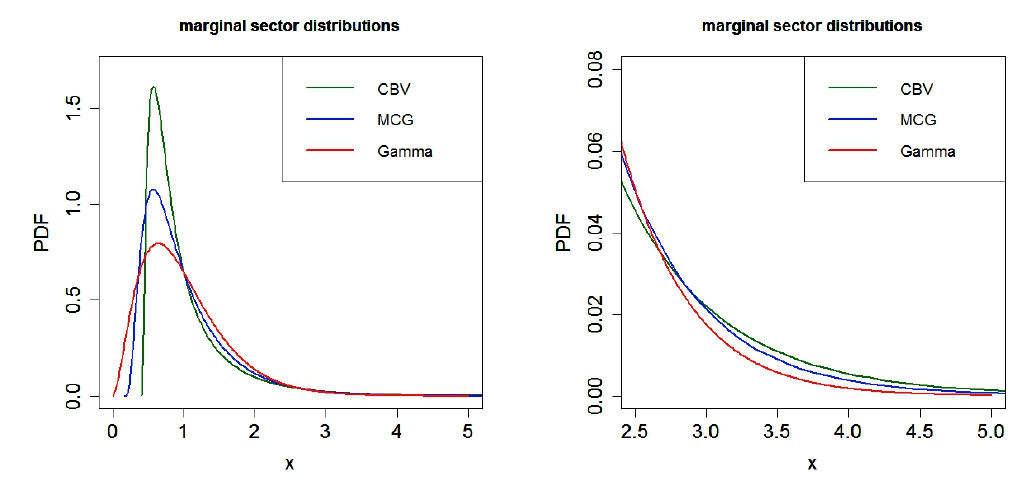
Fig. 8. Densities of sector variable 3 in the CBV (green), the MCG (blue), and the original (red) CreditRisk + model. For other sectors plots are very similar.